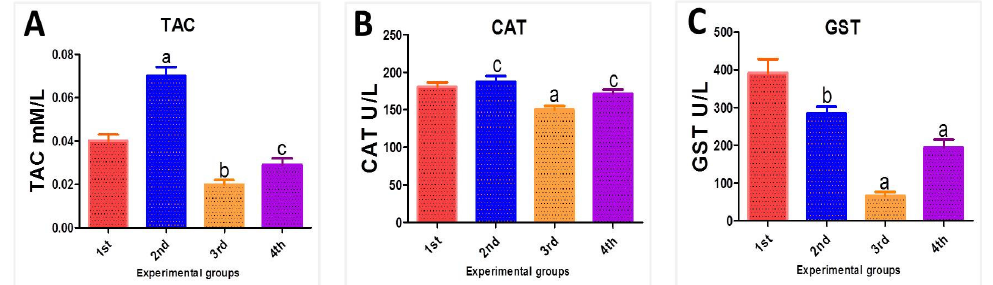
Figure 14. ( A ) Total antioxidant capacity level “TAC” in fresh mice serum, ( B ) Catalase level (CAT) in mice fresh serum, and ( C ) Glutathione S-transferase level (GST) for mice serum of the different